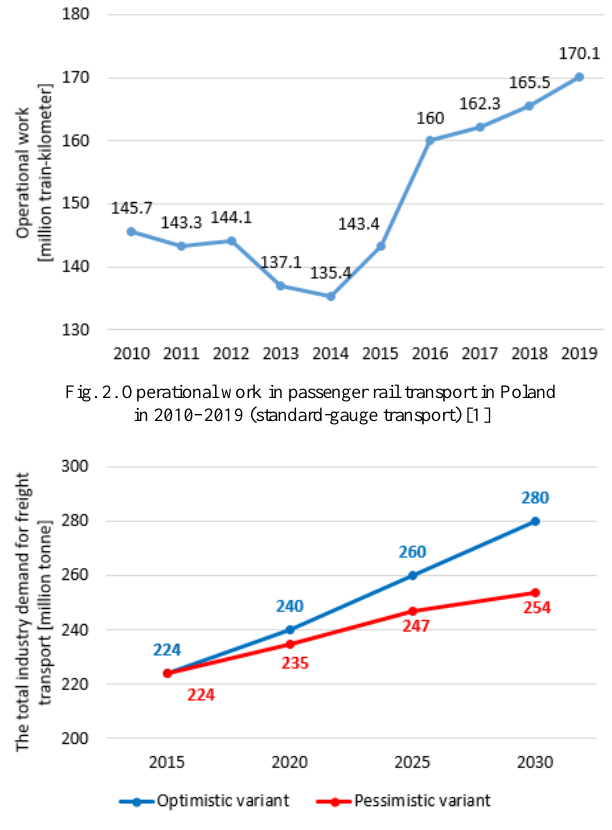
Fig. 3. The projected volume of the total industry demand for freight transport by rail in Poland (carried out by Polish and foreign carriers) [27]